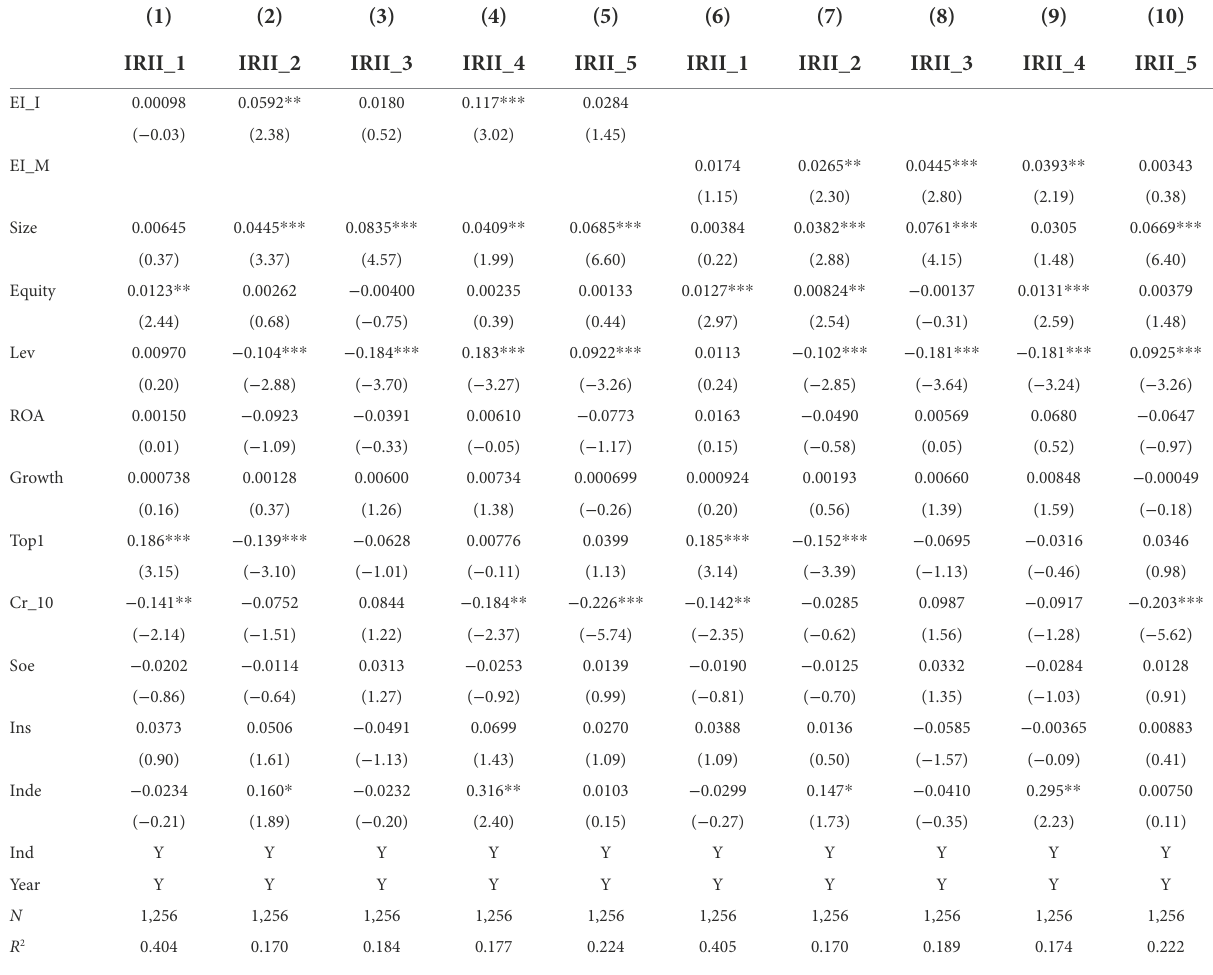
TABLE 9 The impact of EI_I and EI_M on each sub-index of